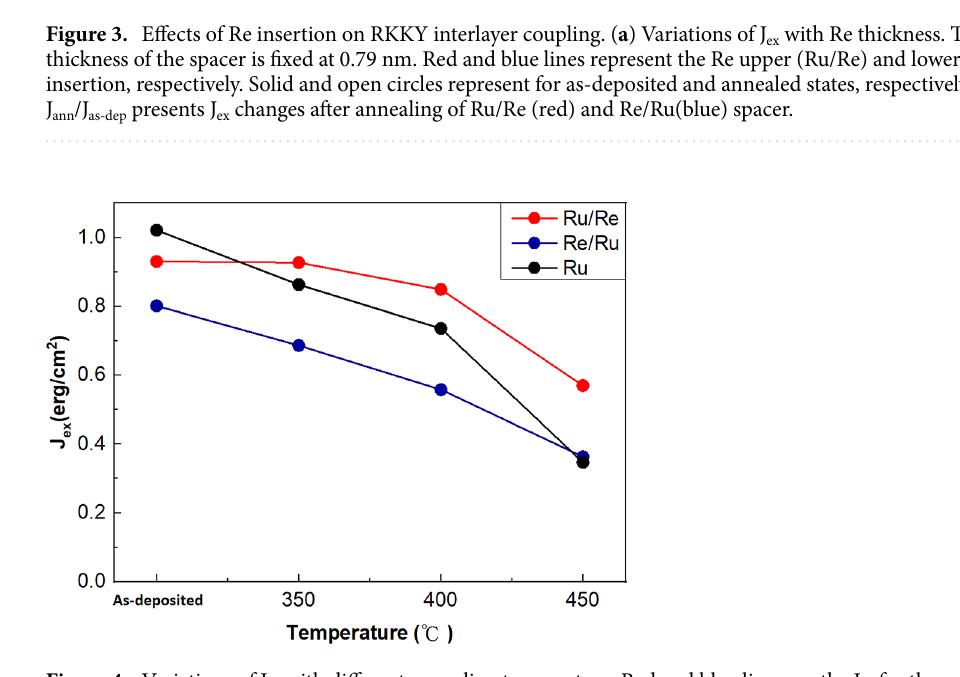
Figure 4. Variations of J ex with different annealing temperature. Red and blue lines are the J ex for the sample with the Ru/Re and Re/Ru spacers, respectively. The thickness for Ru and Re is 0.61 and 0.18 nm, respectively. Black line is the J ex for the sample with Ru spacer (0.79